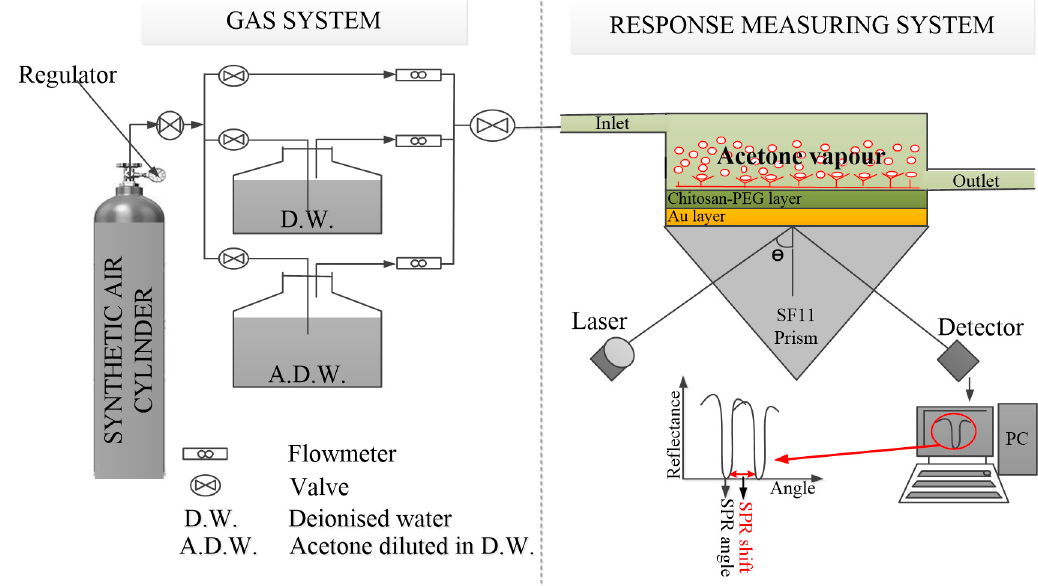
Figure 1. Sketch diagram of the entire surface plasmon resonance (SPR) response testing setup.